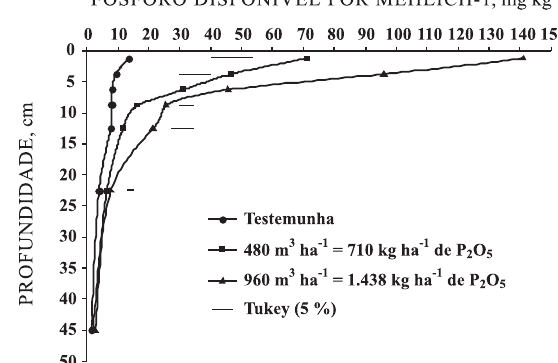
Figura 1. Fósforo disponível extraído por Mehlich-1, média de quatro repetições, num Argissolo conduzido sob sistema plantio direto e submetido a aplicações sucessivas de dejeto líquido de suínos na